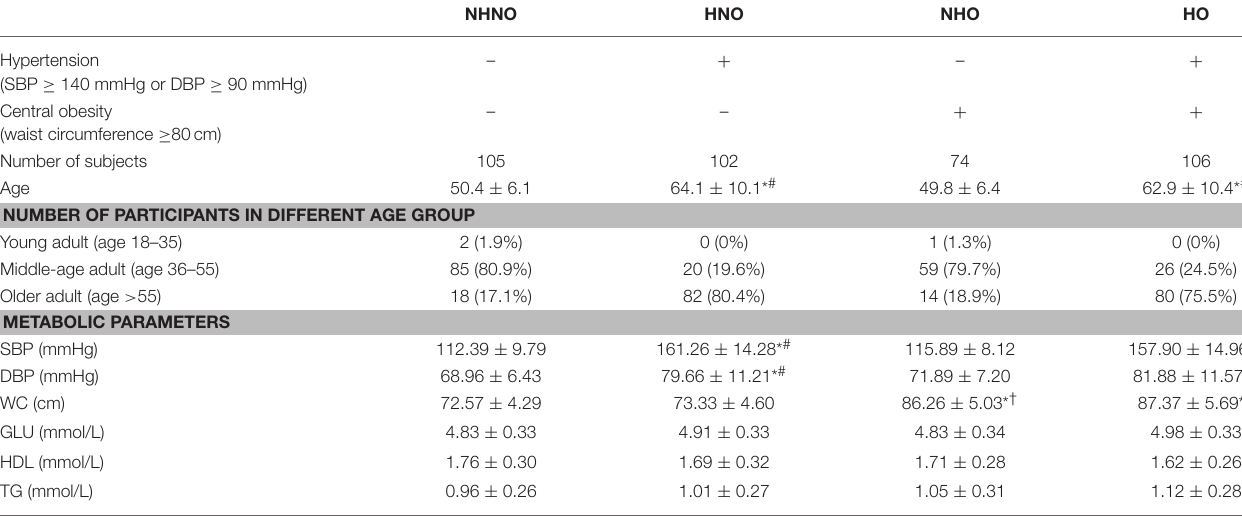
TABLE 1 | Demographic characteristics of participants.